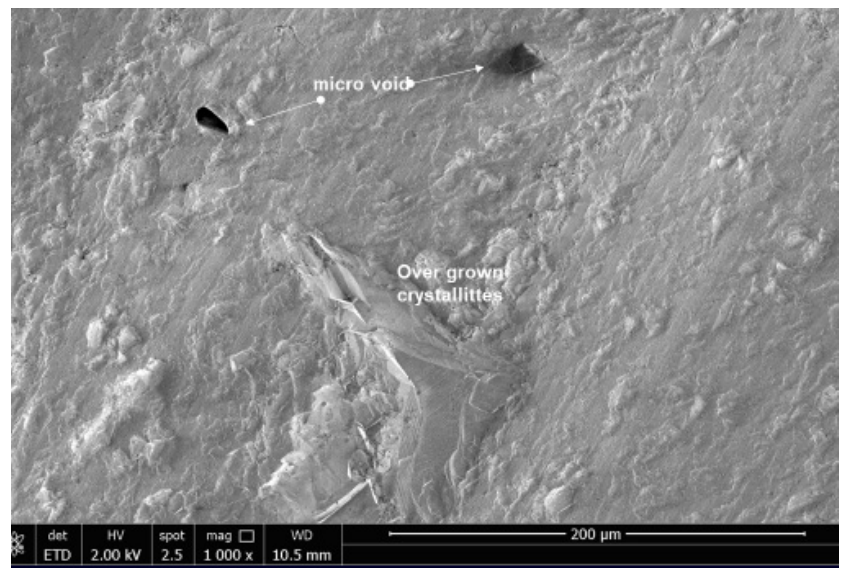
Figure 2. Micromorphology of the sulfur-doped ZnSe slab. Micro voids (dark) and overgrowth were observed in the crystal.